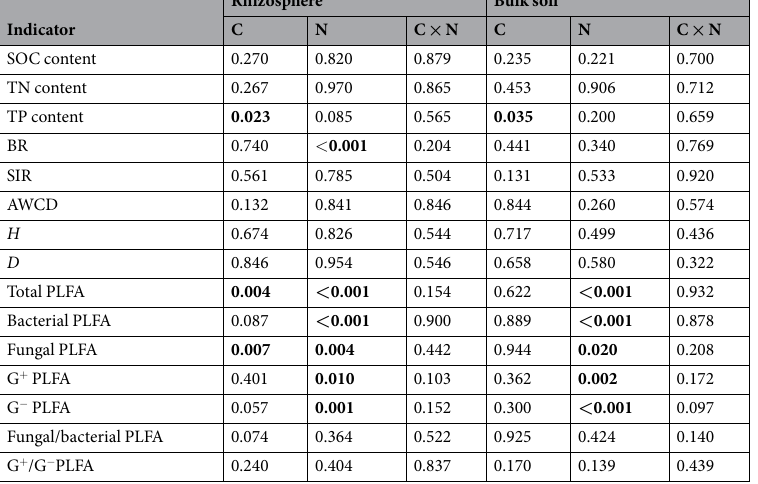
Table 1. P values for the effects of elevated CO 2 (C), N addition (N), and their interaction on chemical and microbial properties in the rhizosphere and bulk soil. Significant P values are highlighted in